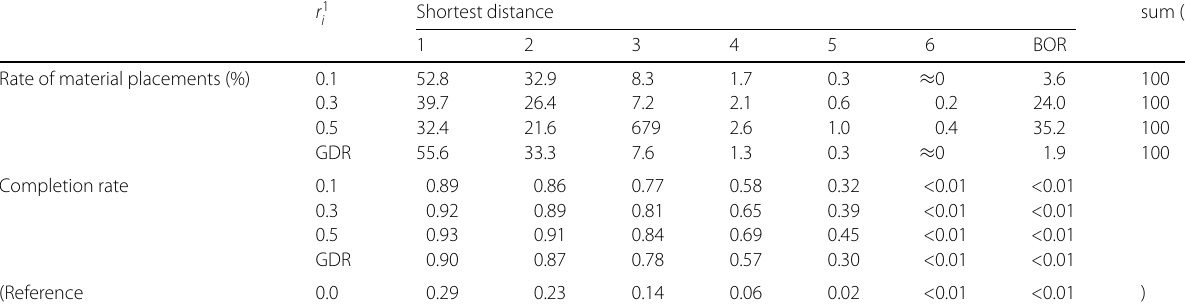
Table 4 Distance to the installation agents and associated task completion rate in Exp.